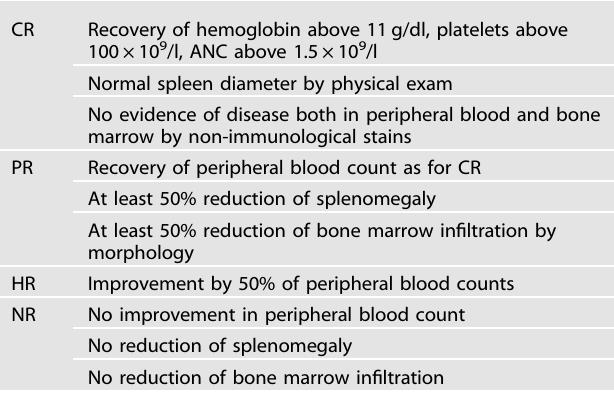
Table 1. De fi nition of response criteria. Table 2. Characteristics of